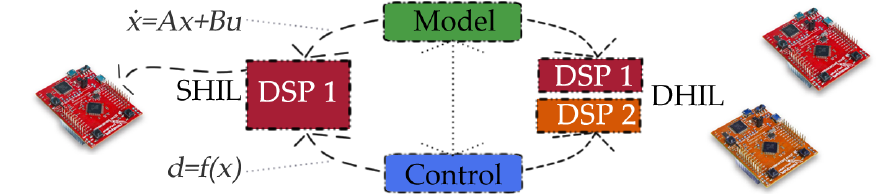
Figure 1. SHIL and